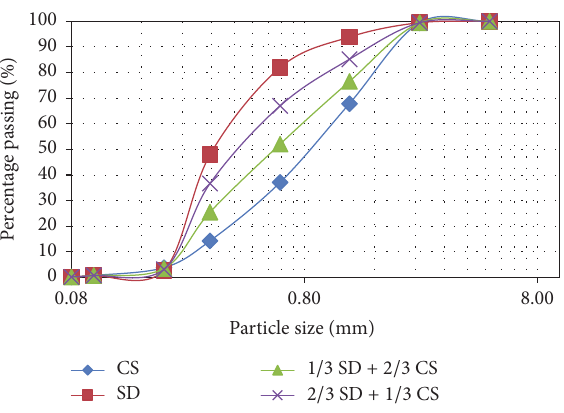
Figure 2: Particle size distribution of the sand studied.